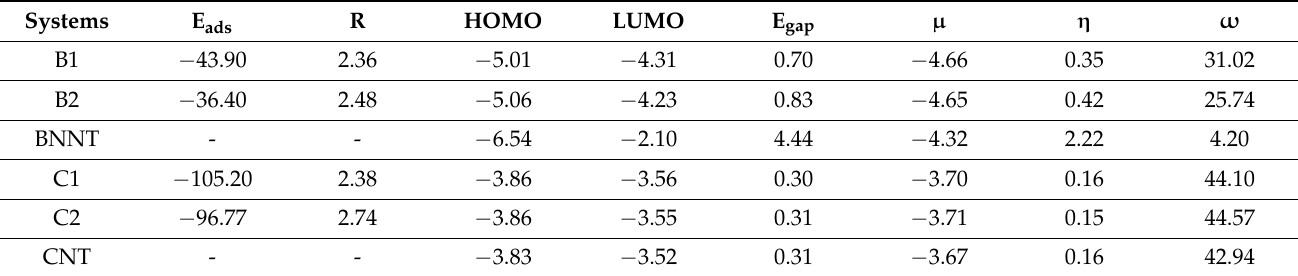
Table 1. Computed adsorption energies (E ads ), closest contact distance (R) between the binding site and the closest atom of the mycolactone molecule, HOMO, LUMO energies, band gap (E gap ), chemical potential ( µ ), global hardness ( η ), and electrophilicity index ( ω ) for the most stable structures of the mycolactone-nanotube complexes. Units for Eads are kcal/mol, other energies in eV, and bond length in